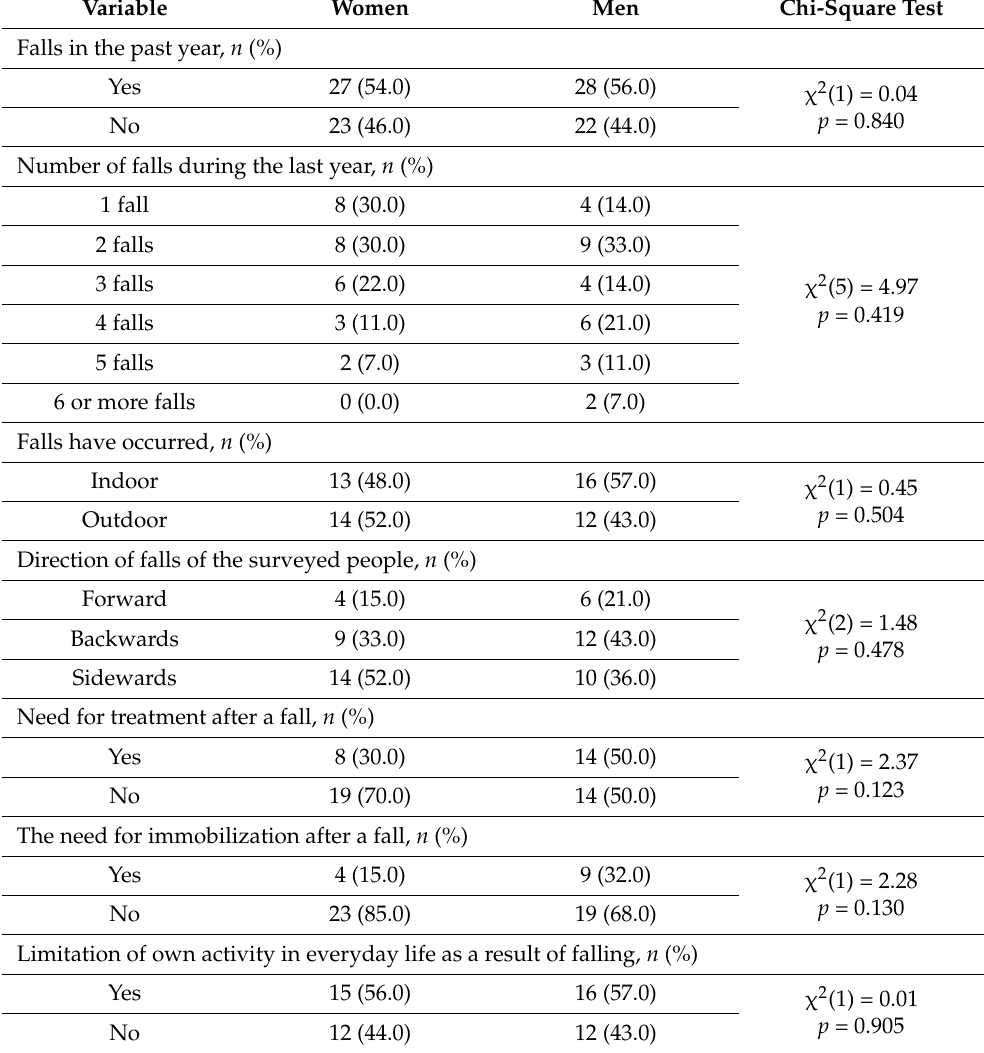
Table 2. Characteristics of the falls experienced by the respondents. Variable Women Men Chi-Square